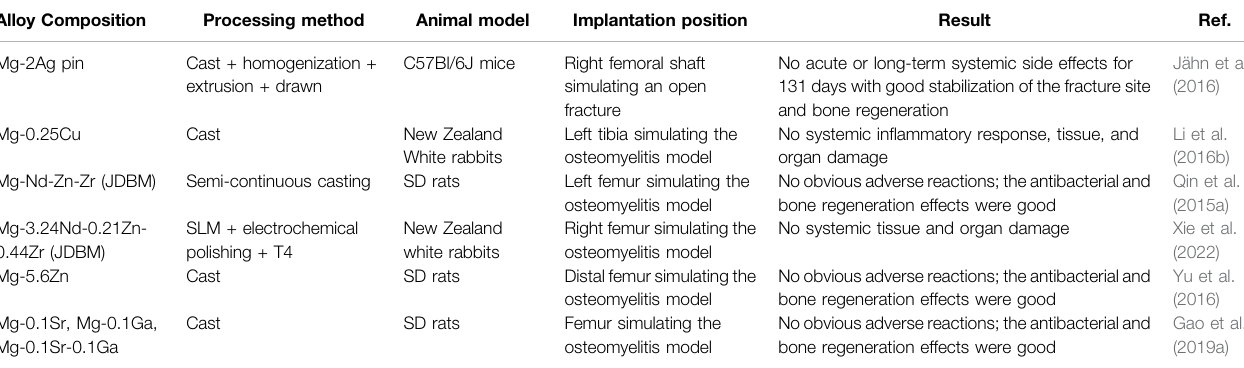
TABLE 5 | In vivo biocompatibility of Mg-based alloys with antibacterial properties as orthopedic implants. Alloy